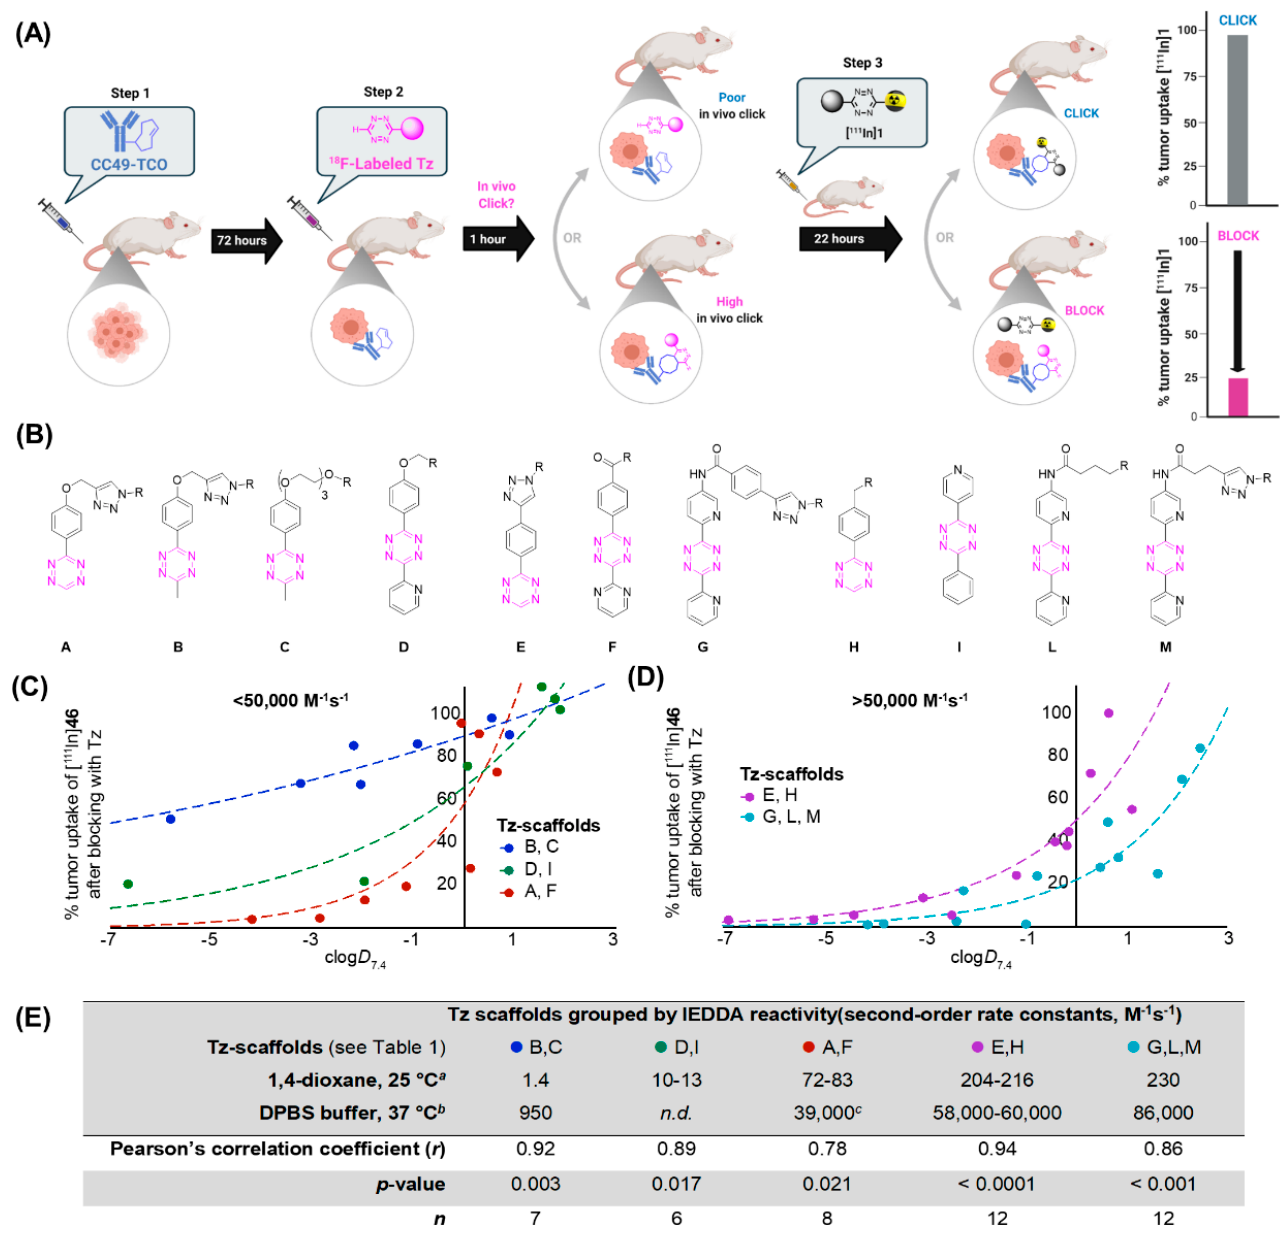
Figure 7. Results from the blocking assay. The blocking effect of non-radiolabeled Tz was calculated as the change in tumor uptake of [ 111 In] 1 22 h p.i. ( A ) General scheme of the blocking assay. First, tumor-bearing mice were administrated with CC49-TCO, 72 h before injection of a nonradioactive Tz. After 1 h, [ 111 In] 1 was injected, and ex vivo biodistribution was performed 22 h p.i. to determine the blocking effect of the non-radiolabeled 19 F-Tz. The uptake was normalized to a group of animals (control) in which no blocking was performed. ( B ) Structural Tz scaffolds. ( C , D ) Correlation of clogD 7.4 and blocking effect for Tz derivatives with alike IEDDA reactivity. ( E ) Statistical analysis of the correlation between blocking and tumor uptake for the different groups of Tz. Pearson’s correlation coefficient (r) describes the fit between the clogD 7.4 and blocking effect. Modified with permission from ACS. Copyright © 2021, American Chemical